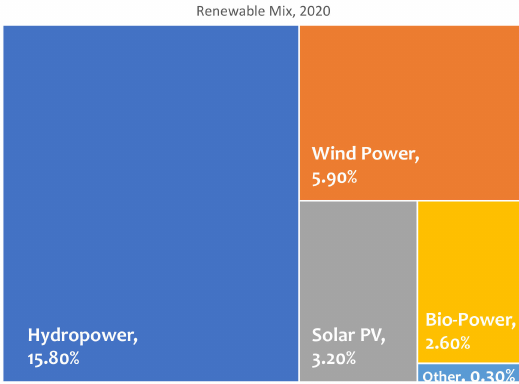
Figure 1. Renewable mix production in 2020 [1].